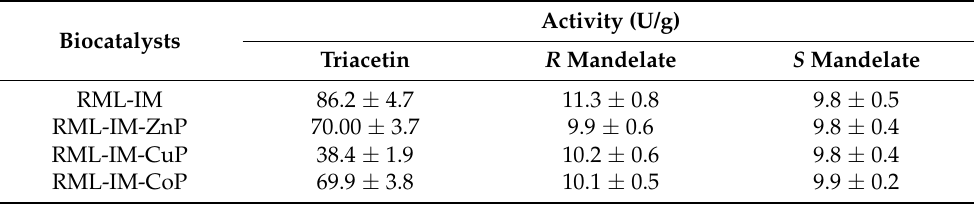
Table 3. Specific activity of different biocatalysts with 50 mM R - or S -methyl mandelate and 50 mM of triacetin (pH 7, 25 ◦ C). Experiments were performed as described in the Methods section. Activity (U/g) Biocatalysts Triacetin R Mandelate